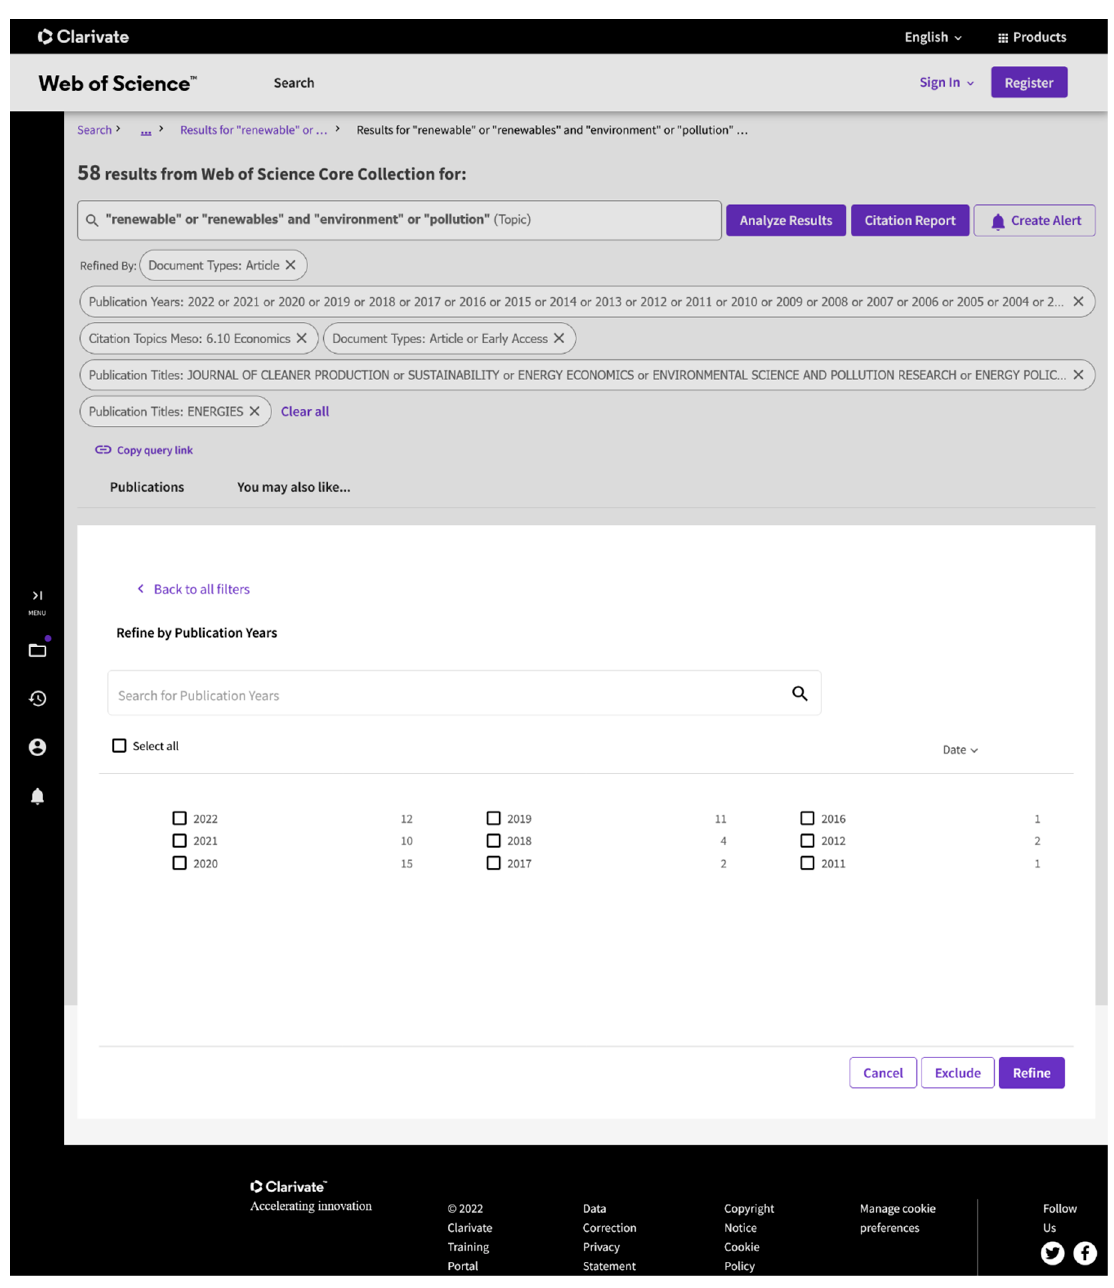
Figure A3. WOS Search– Energies.